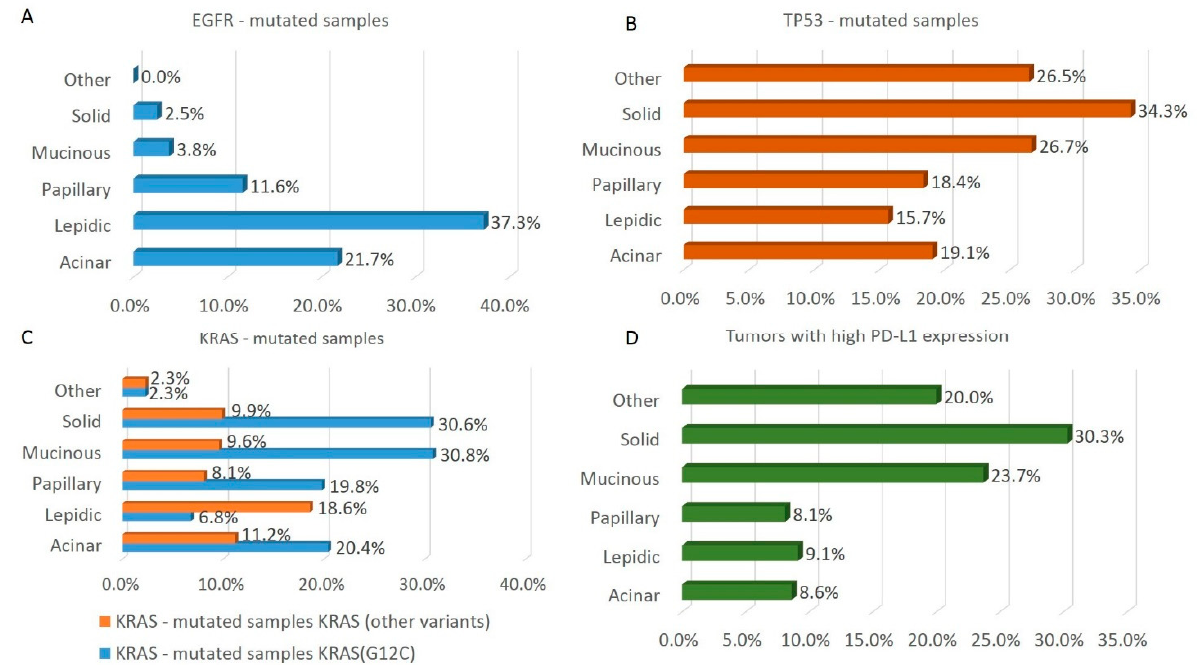
Figure 5. Distribution of histological patterns in EGFR- , TP53- or KRAS -mutated samples and in high PD-L1 expression tumors. ( A ) The percentage of the indicated LUAD histology patterns in EGFR -mutated samples is reported. ( B ) The percentage of the indicated LUAD histology patterns in TP53 -mutated samples is reported. ( C ) The percentage of the indicated LUAD histology patterns in G12C (orange bars) and non-G12C (blue bars) KRAS -mutated samples is reported. ( D ) The percentage of the indicated LUAD histology patterns in tumors with high PD-L1 expression is reported.